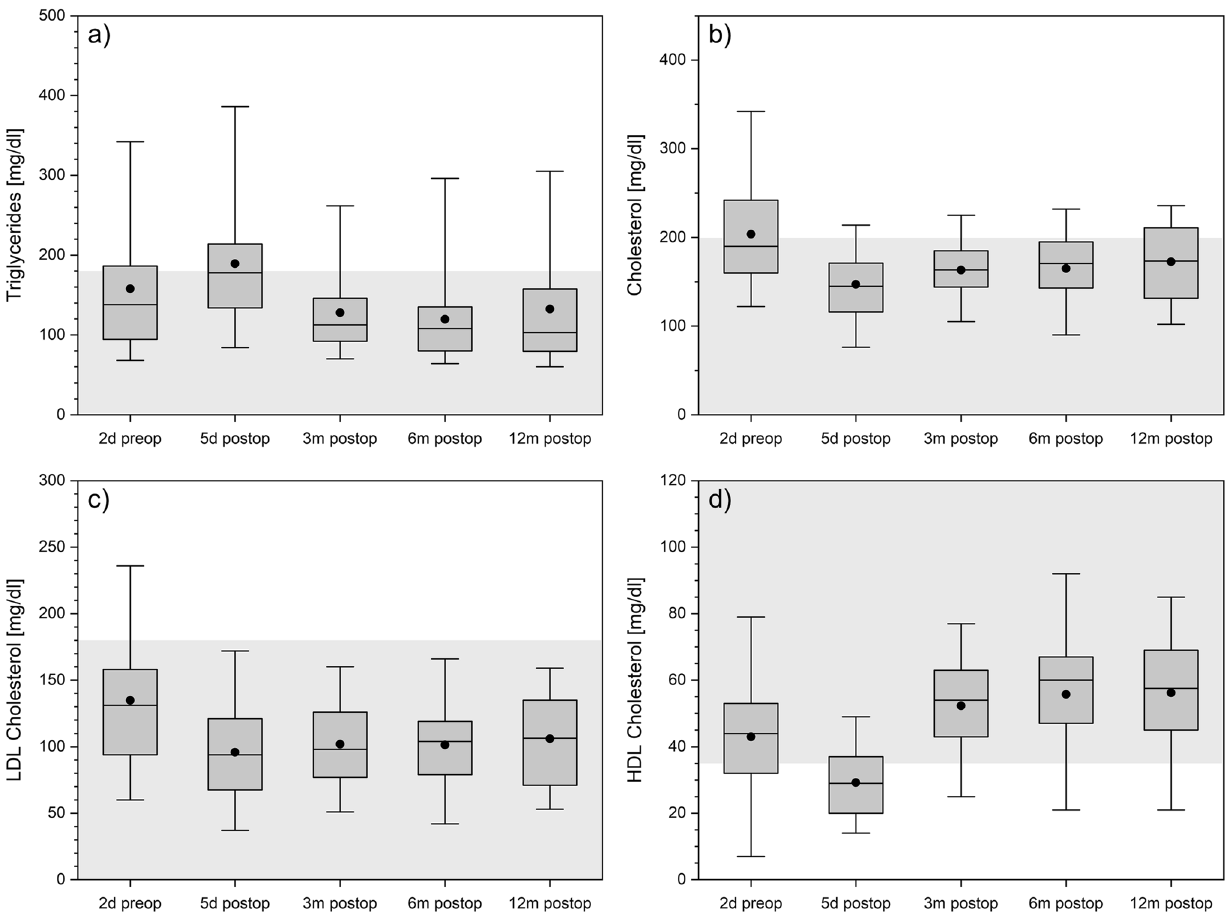
Figure 3. Triglycerides (panel a ), cholesterol (panel b ), LDL cholesterol (panel c ), and HDL cholesterol (panel d ) over time. The boxes contain the 25% and the 75% quartile as well as the median, black dots depict the mean, and whiskers range from the 5% percentile to the 95% percentile. Gray areas depict the normal range for each variable.